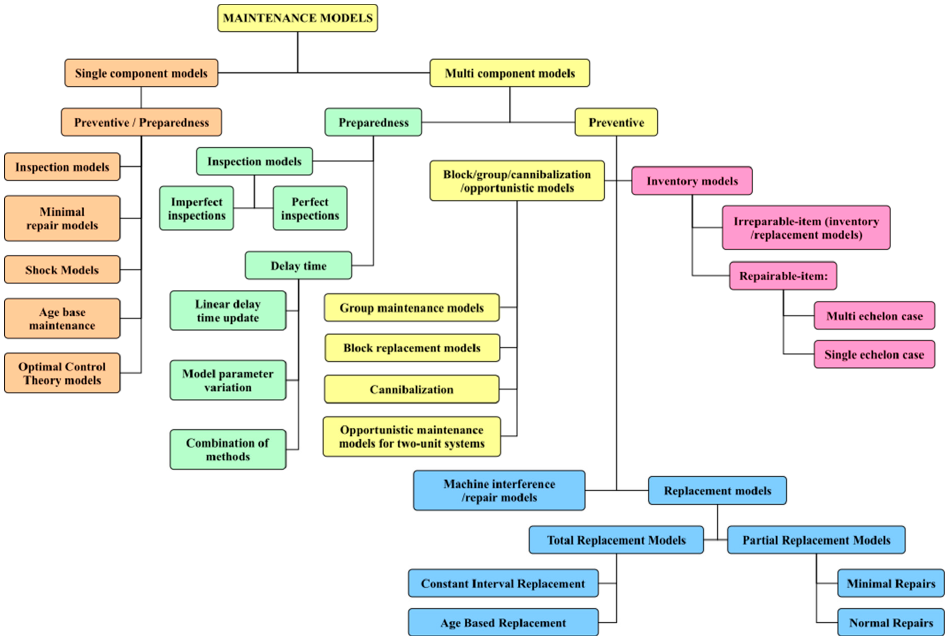
Figure 4. Alternative Classification of maintenance models. “Source [49–53,56–59], own elaboration.”.